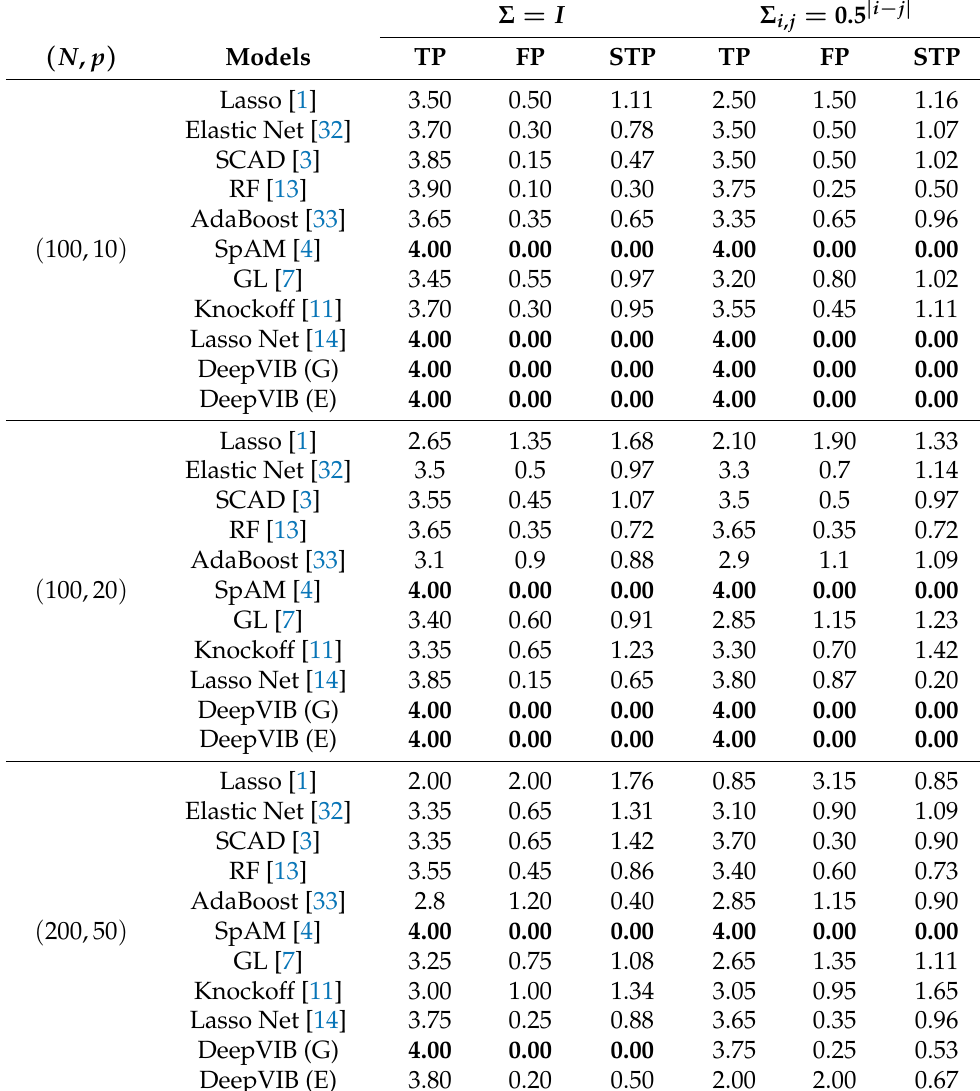
Table 3. The averaged performance of variable selection (Example